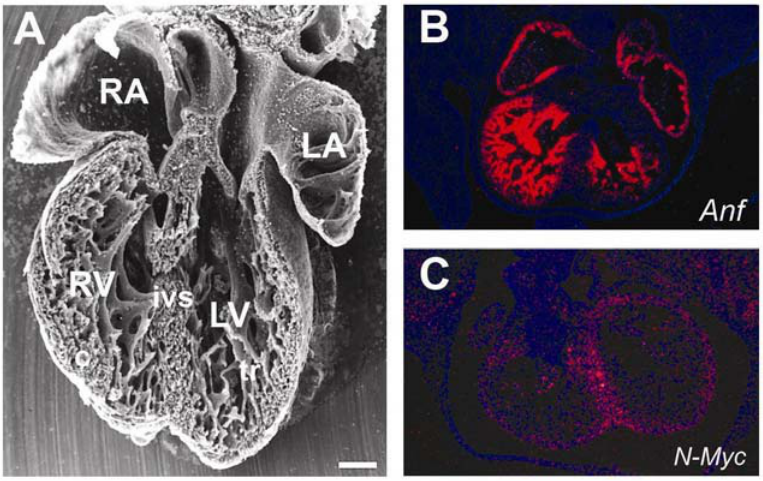
FIGURE 4. Maturation of the ventricles. (A) Scanning electron micrograph of an embryonic mouse heart at E14.5 indicating the presence of trabeculated and compact myocardium, and the fully formed muscular interventricular septum (Scale bar = 100 μ m). Note that the pattern of trabeculations ANF ( Nppa ) does not differ greatly between the two ventricles. (B,C) In situ hybridization for ANF (B) and N-myc (C) on sagittal sections through E10.5 wildtype mouse embryonic hearts. The trabeculated and compact myocardial layers can be demarcated as early as E10.5 by the expression of ANF and N-myc, respectively. LA, left atrium; LV, left ventricle; RA, right atrium; RV, right ventricle; ivs, interventricular septum; c, compact myocardium; tr, trabeculations. A is reproduced from Sedmera et al.[47], ©2000 with permission from John Wiley & Sons Limited; B and C are courtesy of Edward Morrisey, University of